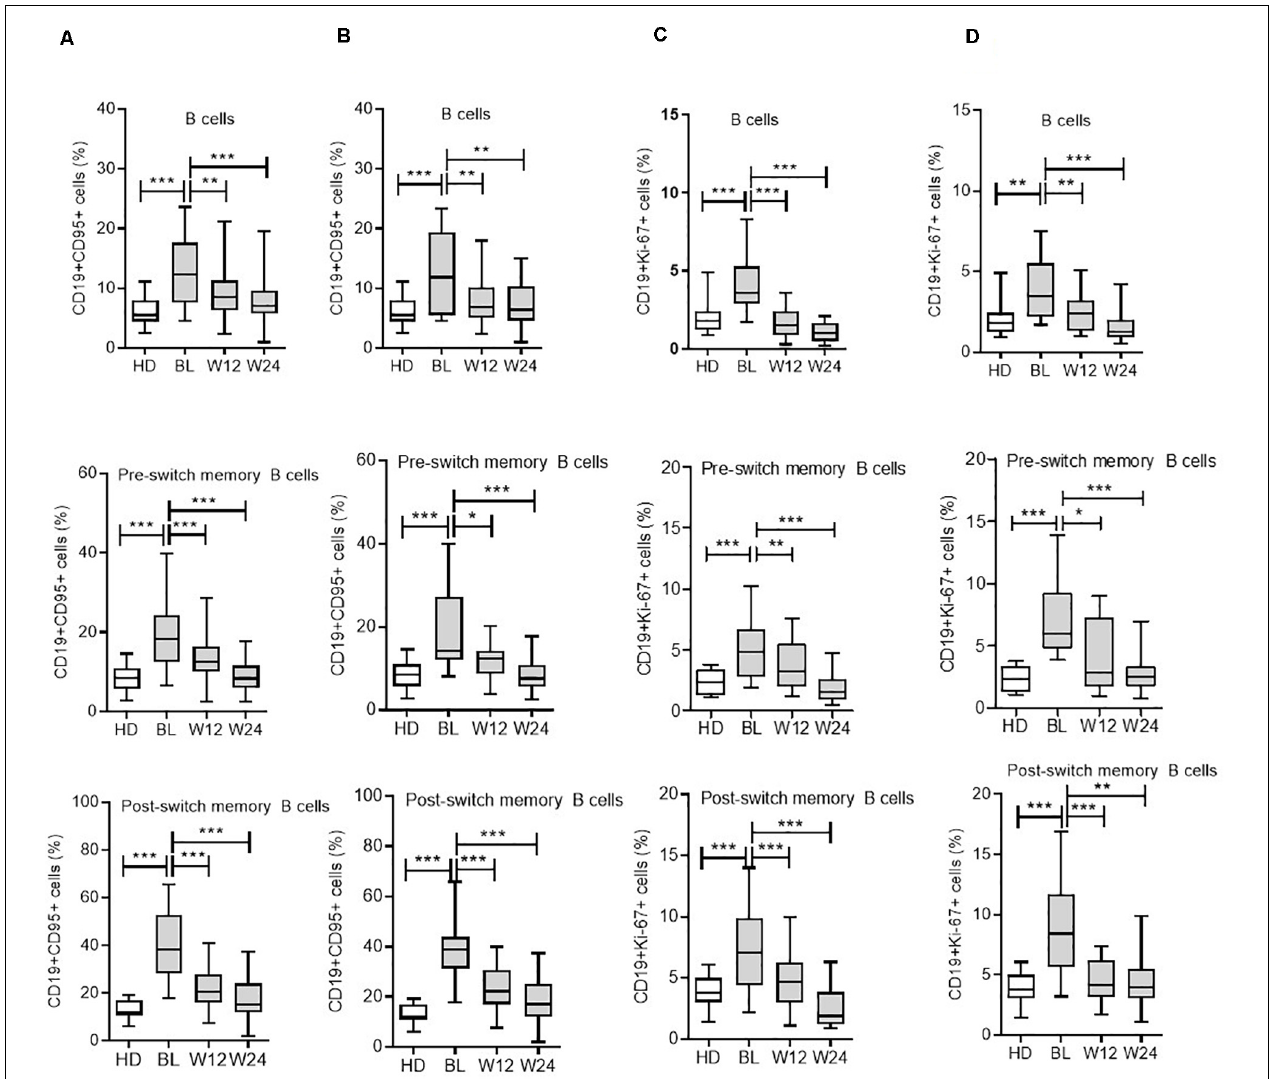
FIGURE 2 | Modulation of CD95 expression on B cell subsets during IL-6R and TNF- α inhibition therapy. For CD19+CD95+ expressing cells from all B cell subsets, including total B cells, pre-switch memory, and post-switch memory B cells, are significantly reduced during IL-6R inhibition (A) and TNF- α inhibition (B) therapy. CD19+Ki-67+ expressing cells from all B cell subsets are significantly reduced during IL-6R inhibition (C) and TNF- α inhibition (D) therapy. Values were consistently compared with baseline levels by using the Student unpaired t -test (*** p < 0.0001, ** p < 0.001, and * p < 0.01). BL = baseline, W12 = week 12, and W24 = week 24.